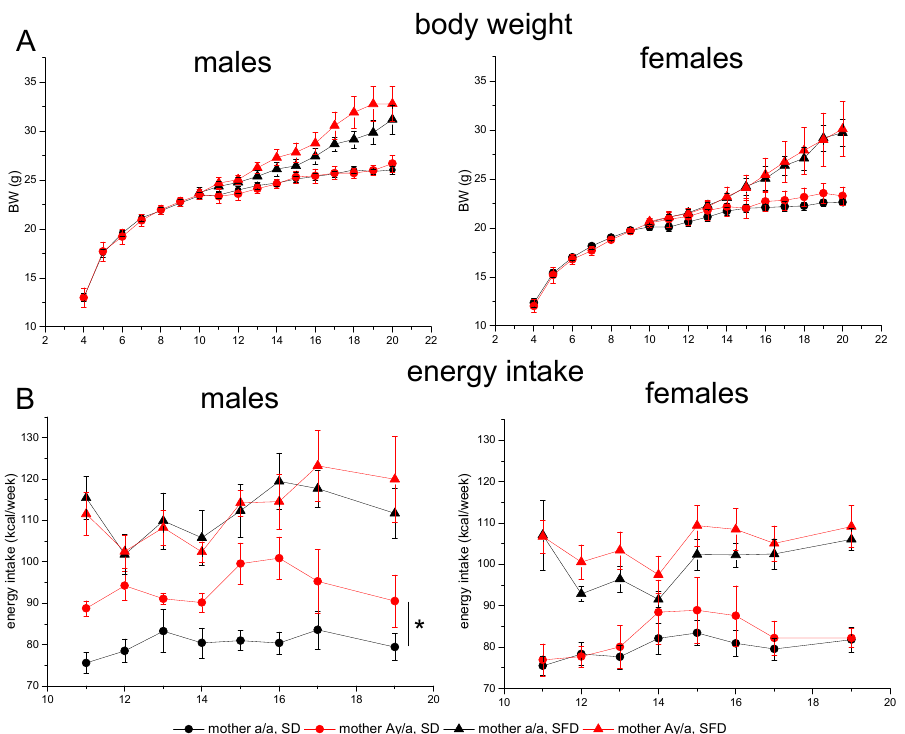
Figure 2. Influence of maternal obesity on body weight ( A ) and weekly energy intake ( B ) in male and female offspring consuming SD or SFD diets. Male and female offspring of obese ( A y /a ) and control ( a/a ) mothers were fed with SD or SFD for 10 weeks from the age of 10 weeks. Data are presented as mean ± SE. The number of animals in groups is shown in Table 2. Data were analyzed by repeated measures ANOVA with factors “sex”, “diet” and “maternal genotype (MG)” for all groups and separately for males and females that consumed different diets with factor “MG”: * p < 0.05; MG, repeated measures ANOVA for SD-males. Axis X designates mouse age (weeks).